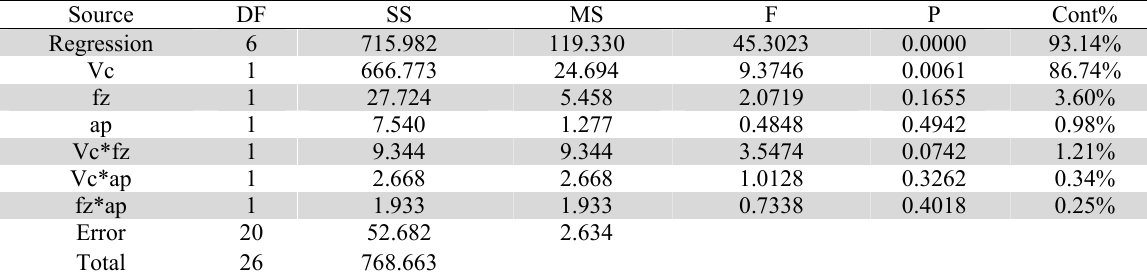
Analysis of variance for the surface roughness Ry Source